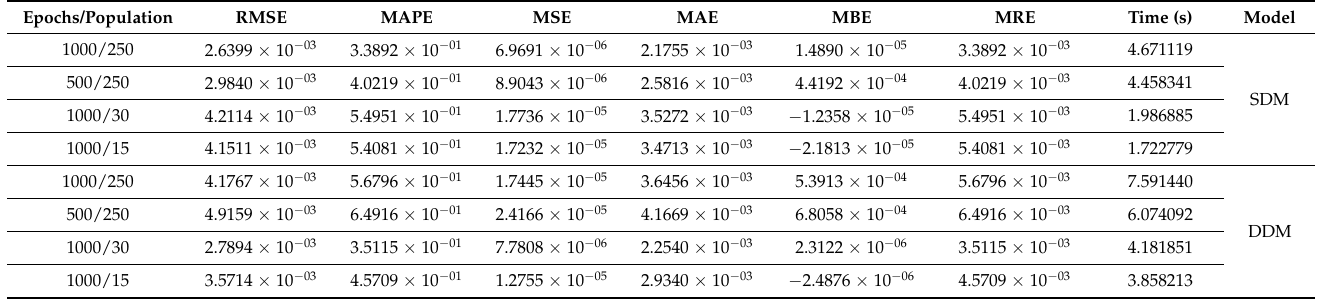
Table 25. Influence of the epochs and population on the statistical tests, PWP201 photovoltaic